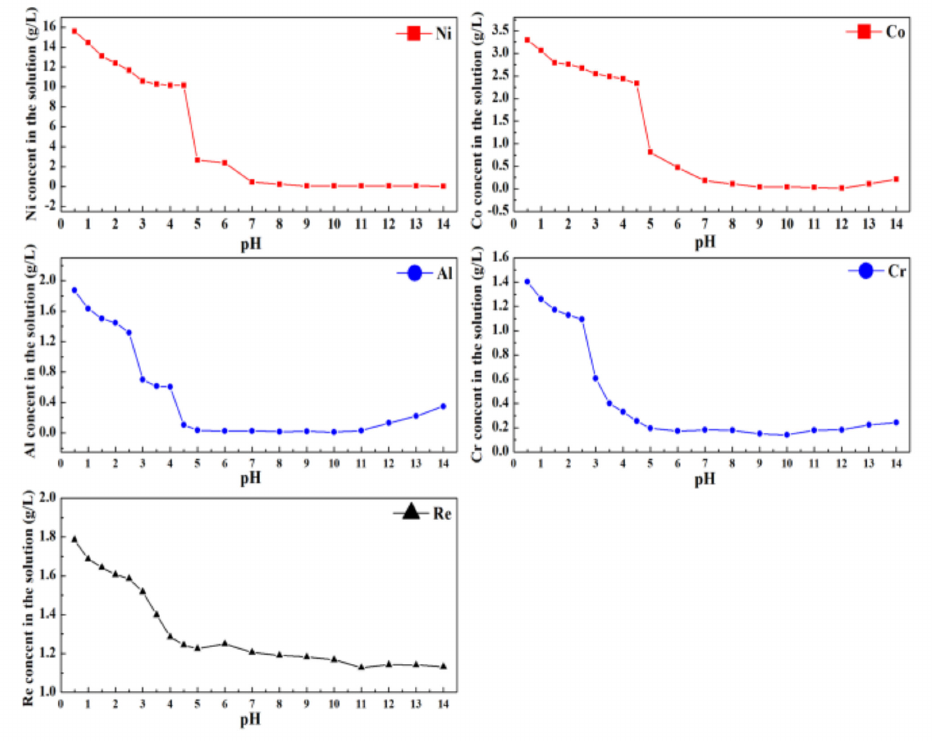
Figure 9. The content of rare metals ions in leaching solution at different pH values.